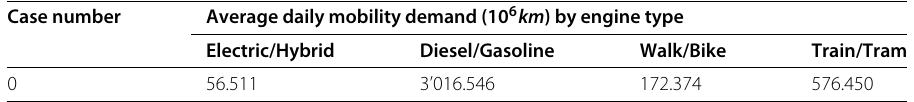
Table 3 Result of daily average mobility demand (10 6 km ) by engine type in scenarios of